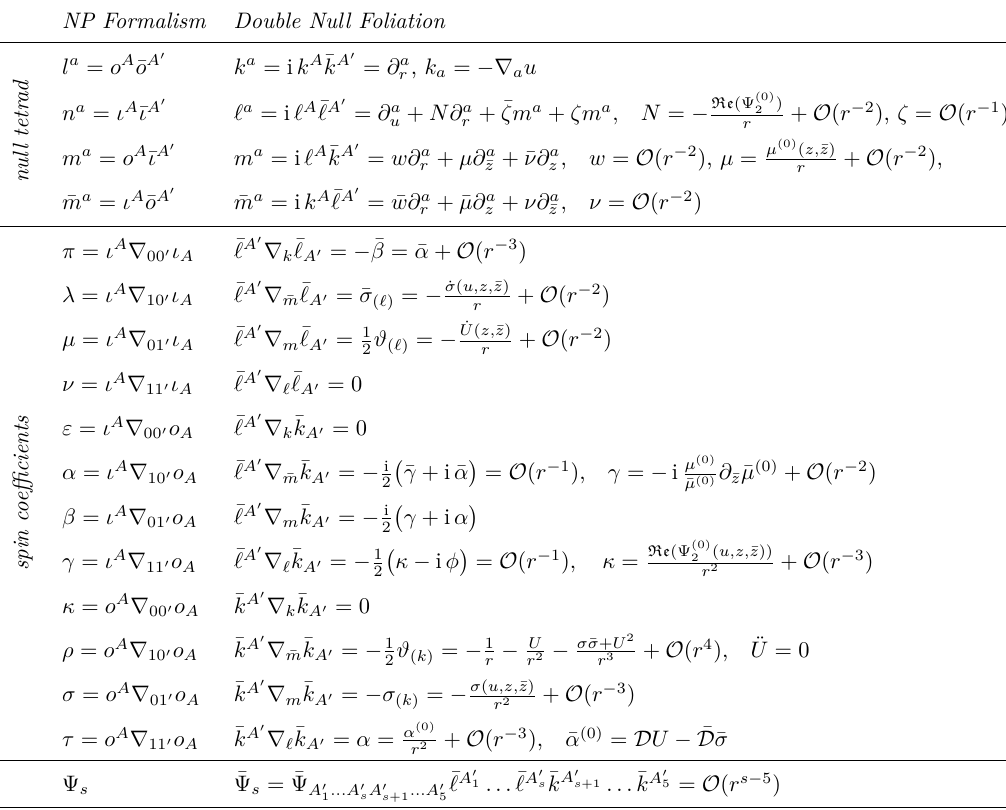
Table 2 . Dictionary between the Newman-Penrose (NP) formalism and the conventions used in this paper. Our metric signature is ( − +++) . Spacetime vectors V a correspond to anti-hermitian (1 / 2 , 1 / 2) spinors V AA 0 = − ¯ V A 0 A . The role of primed and unprimed indices are switched by parity. What we call e.g. Ψ 2 corresponds, therefore, to ¯Ψ 2 in the NP formalism. Notice that both k a and ‘ a are surface